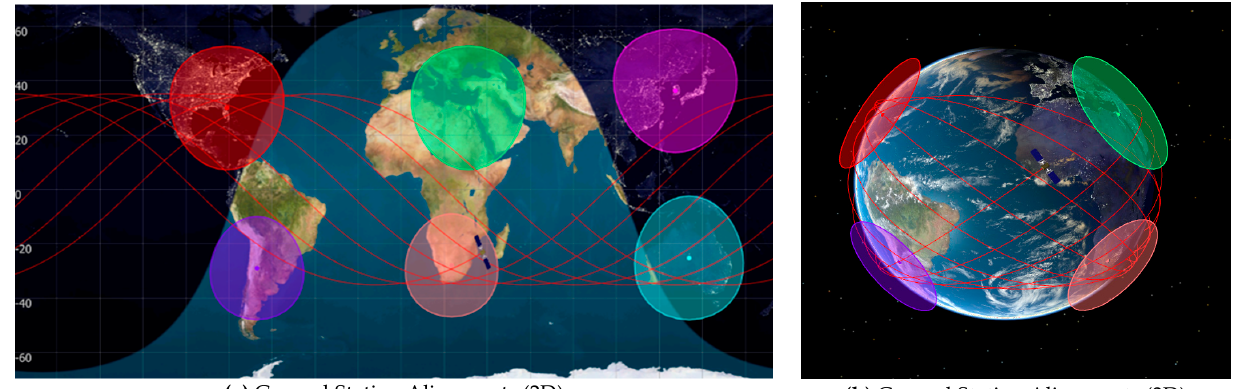
Figure 12. Ground station arrangements in body-fixed frame.